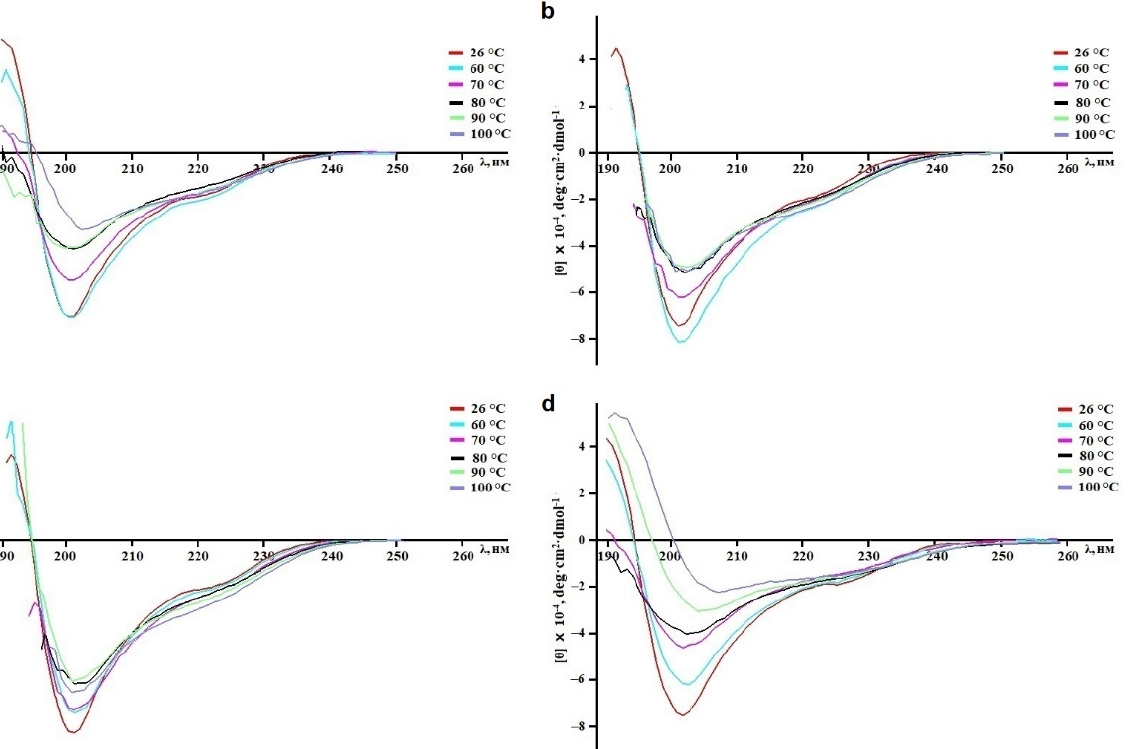
Figure 6. The effects of temperature on the trypsin-inhibitory activity levels of peptides. Peptides were incubated at the temperatures for 30 min and their residual activities were measured. 2.6. The Influence of the Peptides on 6-OHDA-, Paraquat-, Rotenone-, and MPP + -Induced Toxicity The peptides were tested for cell viability in in vitro 6-OHDA-, rotenone-, paraquat- , and MPP + -induced Parkinson’s disease models. All peptides were non-toxic on Neuro- 2a cells at a concentrations up to 10 µM (Figure S2). The viability of neurotoxin-treated cells was about 65% versus control (Figure 7). The peptide HCIQ1c9 at concentrations from 0.1 to 10 µM did not influence the viability of 6-OHDA-treated cells in contrast to HCIQ4c7 and HCIQ2c1, increasing the cell viability in this model by 14% and 47%, re- spectively [43]. The peptides HCIQ2c1 and HMIQ3c1 at concentrations up to 10 µM did not influence the viability of paraquat-treated cells, while HCIQ4c7 and HCIQ1c9